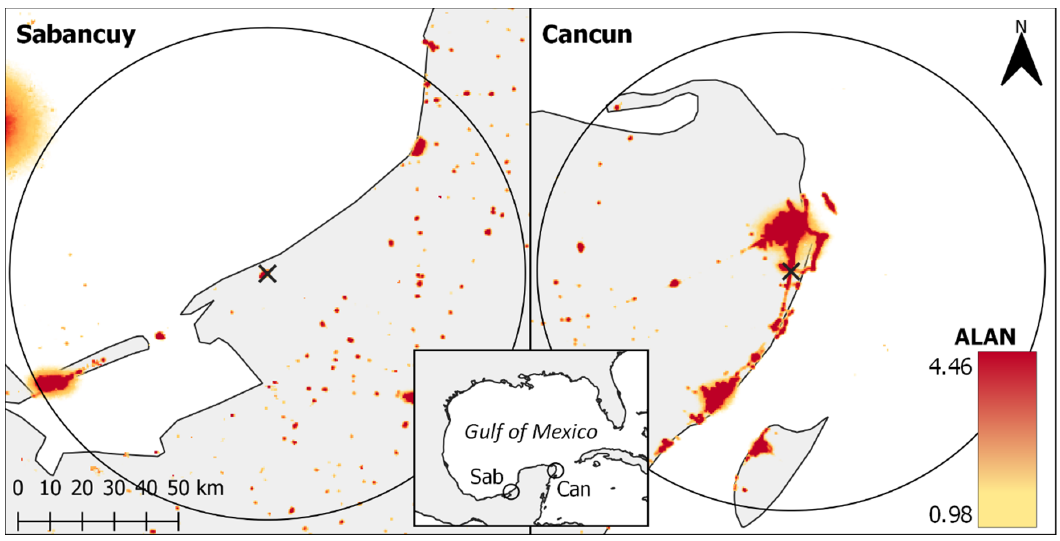
Figure 1. Location (black crosses) and 80 km detection range (black circles) of the Sabancuy (Sab) and Cancun (Can) weather radars in the Yucatan Peninsula showing the average intensity of artificial light at night (ALAN) during spring and fall migration of 2012 (https://ngdc.noaa.gov/eog/viirs/download_dnb_composites.html). Central inset shows the location of the radars in relation to the Gulf of Mexico. Scale bar of ALAN intensity is common to both figure panels and is based on radiance values around Cancun expressed in units of nanoWatts per square centimeter per steradian (nW cm 2 sr).